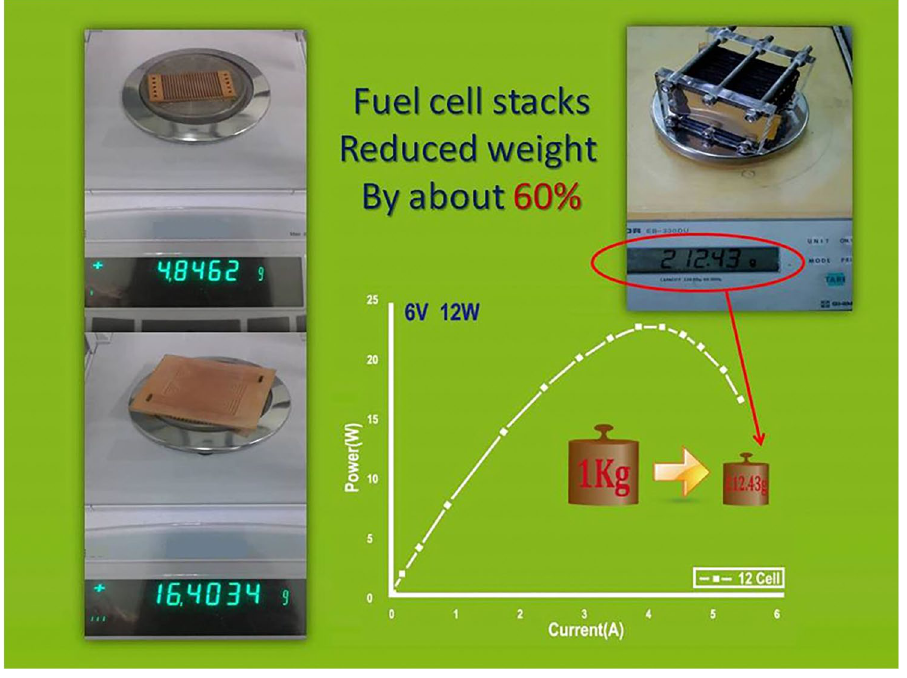
Figure 14. Weight of metal-coated PMMA battery